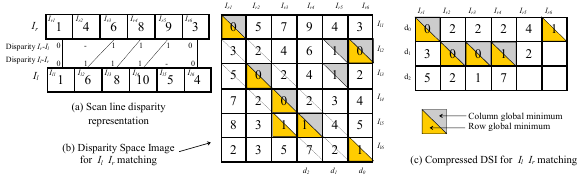
(a) Scan line disparity representation (b) Disparity Space Image (c) Compressed DSI for I l I r matching for I l I r matching Figure 2: (a) Two scan lines I { 1 , 4 , 6 , 8 , 9 , 3 } and l I r { 1 , 6 , 8 , 10 , 5 , 4 } of image pair I and I r (b) DSI for l lr I −→ I r matching (c) compressed DSI c l lr (Heinrichs et al., 2007) used similar representation and solved the stereo matching using the Cooperative Algorithm for random dot stereogram. The same structure has been termed as the Un- compressed Correlation Array in approach as in by (Cochran and Medioni, 1992). They used a composite approach of the feature and area based matching using DSI. (Intille and Bobick, 1994a, Intille and Bobick, 1994b) used the Dynamic Programming (DP) to determine disparity using DSI. They also explained the forma- tion and mathematical representation of DSI in a very lucid man- ner. Later on DSI has been extensively used involving Dynamic Programming approach for the stereo matching. For a stereo pair ( I − I r ) images ; in ideal case the size of DSI is ( n × n ) , where l the cost function C ( i 0 , j, d ) is given as | I ( i 0 , j ) − I r ( i 0 , j + d ) | l